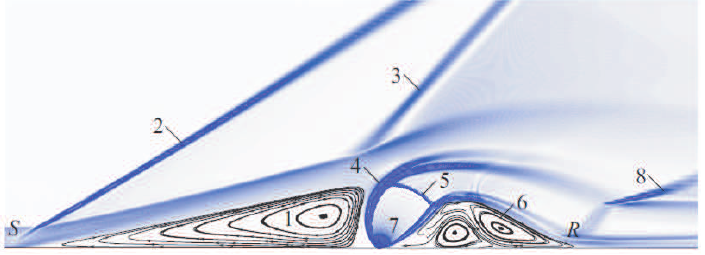
Figure 15. Structure of the flow formed as a result of jet injection into the supersonic crossflow.